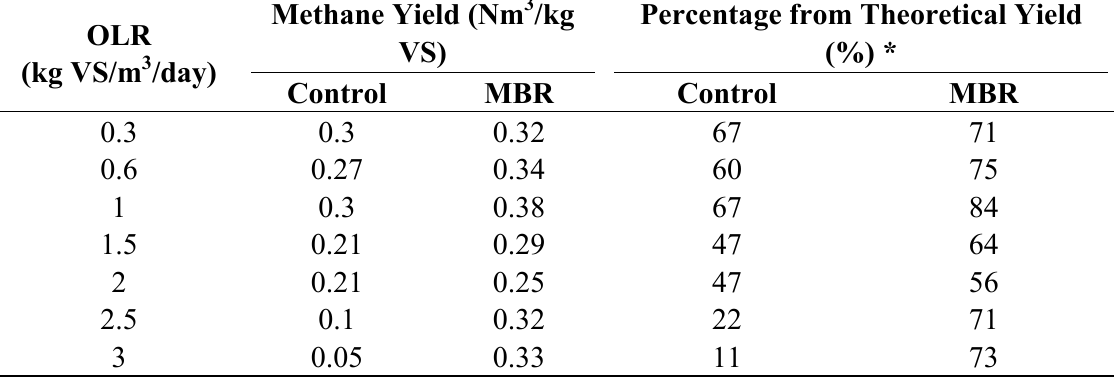
Table 1. Methane yield of anaerobic digestion from citrus waste using membrane bioreactor (MBR) and free cell at different organic loading